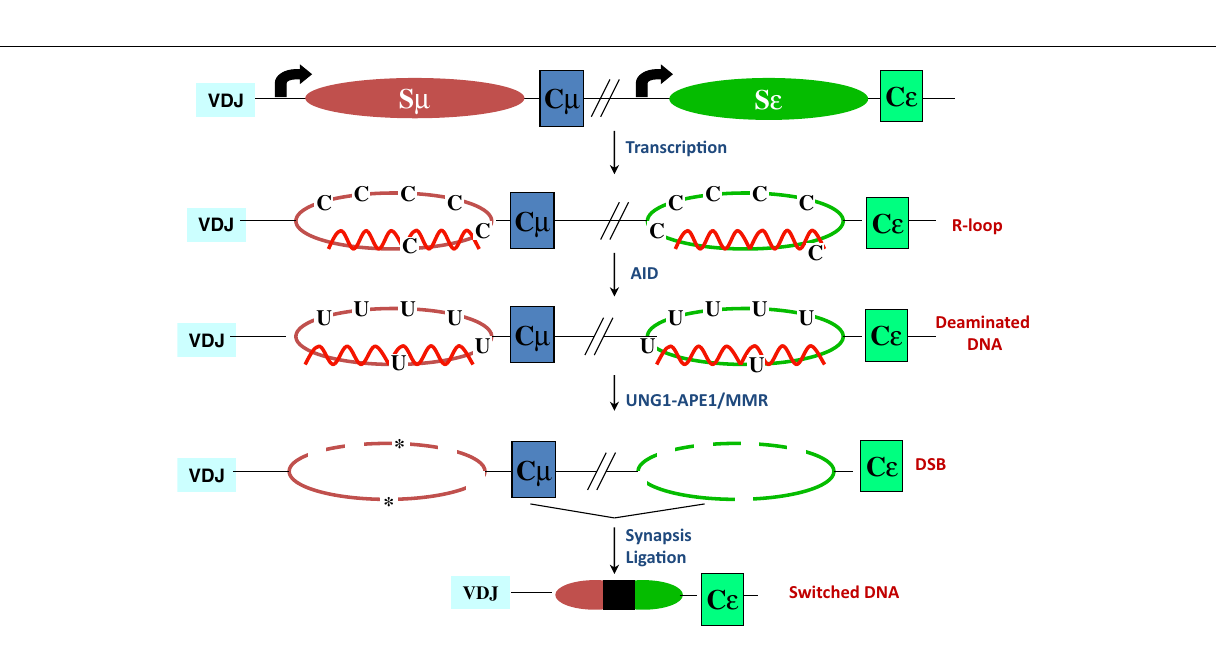
gone into the characterization of its enzymatic properties.